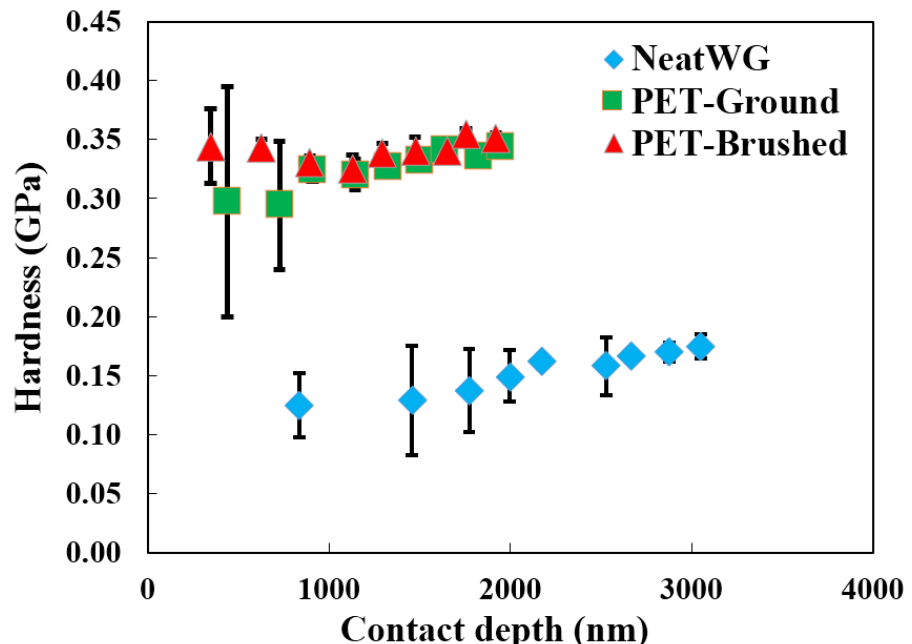
Figure 2. Nanoindentation hardness measured